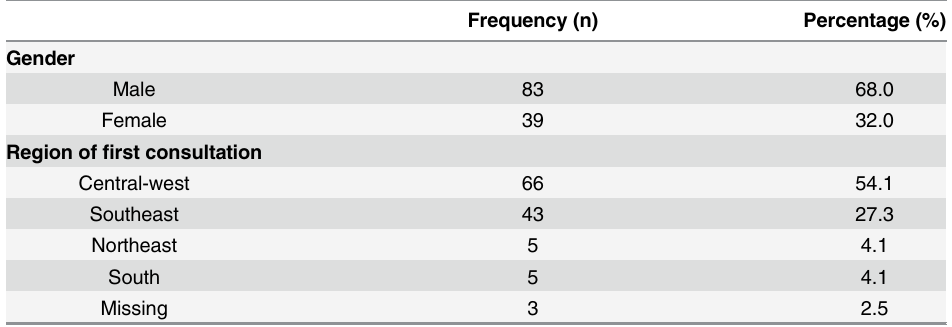
Table 2. Frequencies and percentages of participants ’ personal and household incomes and highest level of education. Personal